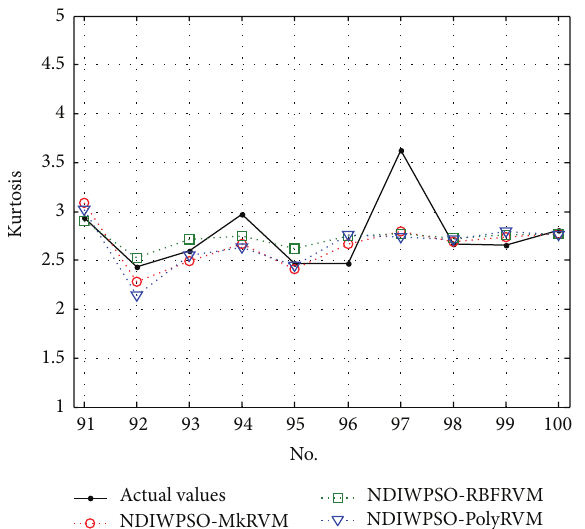
Figure 4: The comparison of the prediction results for kurtosis of bearing vibration signal among NDIWPSO-MkRVM, NDIWPSO- RBFRVM and NDIWPSO-PolyRVM in case 2.